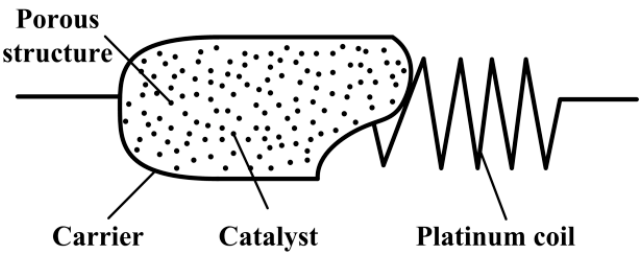
Figure 1. Structure of the micropellistor in a catalytic gas sensor.